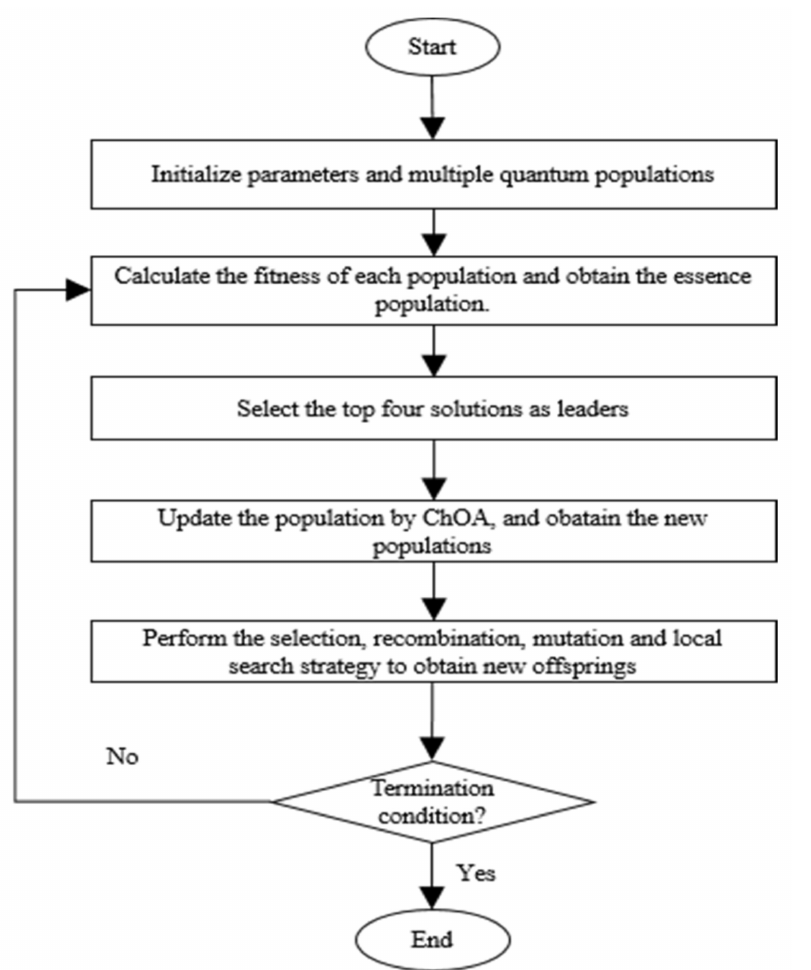
Figure 7. The flowchart of the proposed MG-ChOA